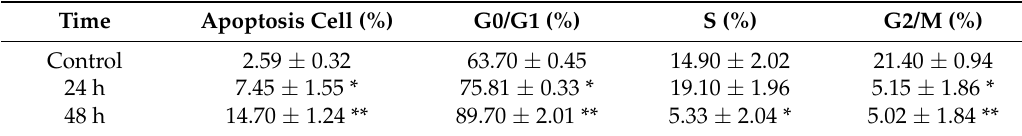
Table 2. Effect of EPS-3a on cell cycle distribution of HepG2 Cells ( n =